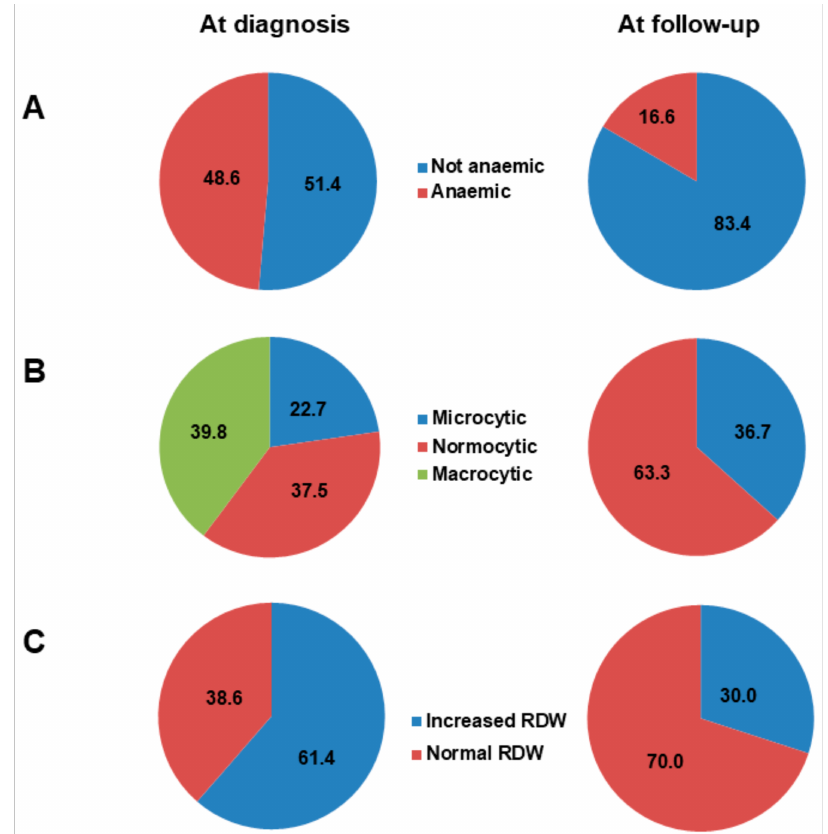
Figure 3. Sub-analysis of a cohort of 181 patients (mean age 59.2 ± 14.6 years, female: male ratio = 2.7:1) who were followed-up for at least one year. The figure shows the proportion of patients with and